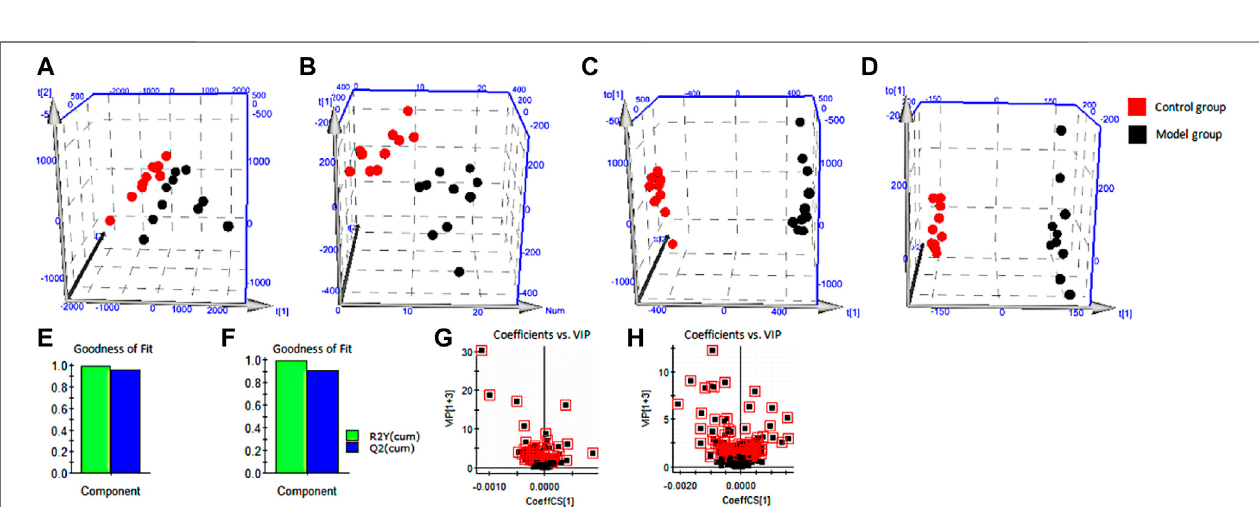
FIGURE4 | Multivariate statistical analysis. (A) PCA score plotsfor the control group and the model group in positive ionmode. (B) PCA score plots for thecontrol groupandthemodelgroupinnegativeionmode. (C) OPLS-DAscoreplotsforthecontrolgroupandthemodelgroupinpositiveionmode. (D) OPLS-DAscoreplotsfor the control group and the model group in negative ion mode. (E) Evaluation of stable and reliable parameters of OPLS-DA model in positive ion mode. (F) Evaluation of stable and reliable parameters of OPLS-DA model in negative ion mode. (G) Serum biomarkers in the VIP between the control group and the model group in positiveionmode. (H) SerumbiomarkersintheVIPbetweenthecontrolgroupandthemodelgroupinnegativeionmode.PCA,principalcomponentanalysis;OPLS-DA, orthogonal partial least squares discriminant analysis; VIP, variable importance in projection.